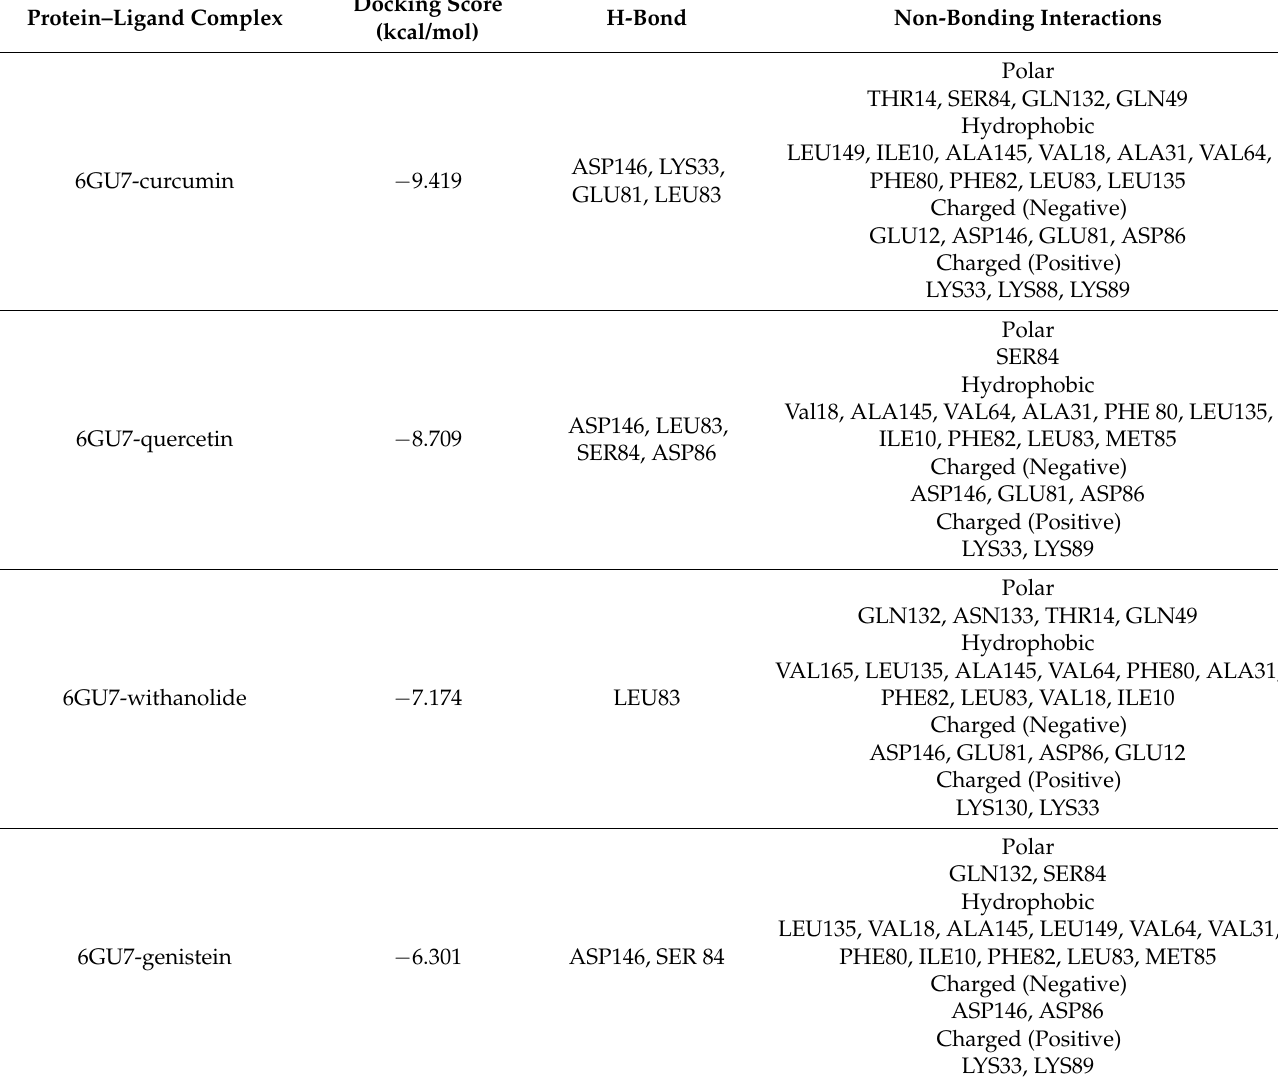
Table 1. The XP docking scores with different binding interactions. Protein–Ligand